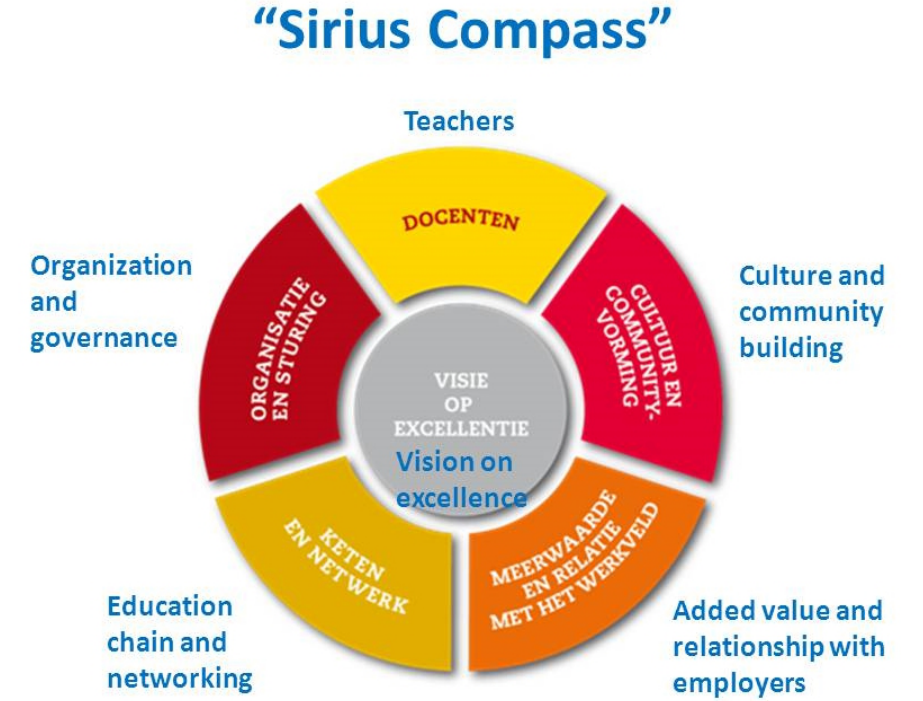
Figure 1: The Sirius Compass for auditing honours programmes in The